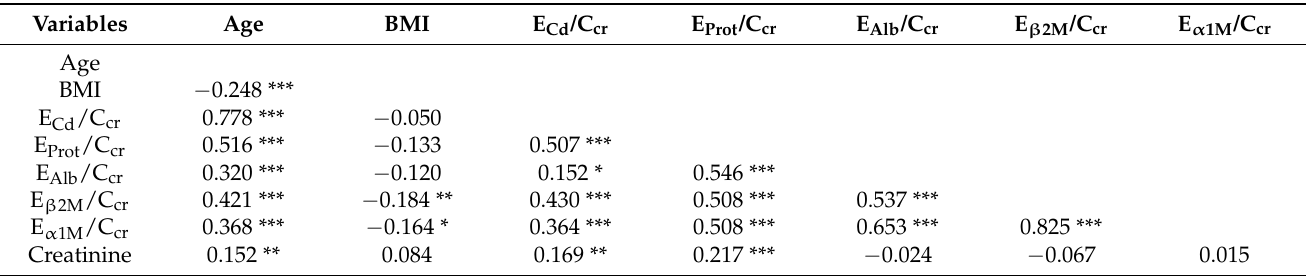
Table 6. The Pearson correlation analysis of chemical compositions of urine samples from 215 resi- dents of a high-exposure area.